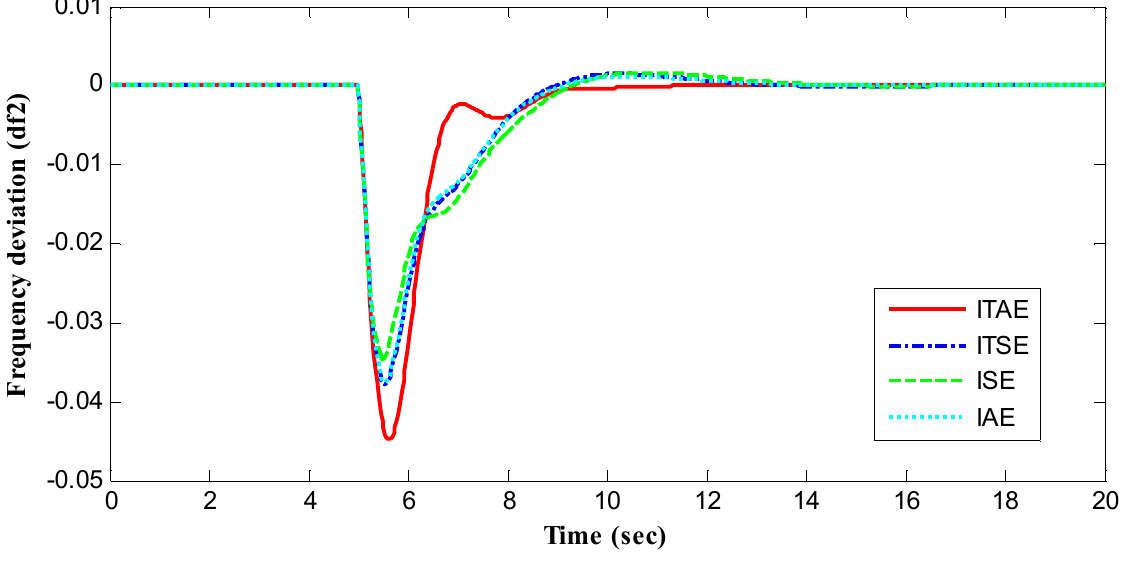
Figure 13. Frequency deviation ∆ f 2 implementing performance objectives used in the literature.